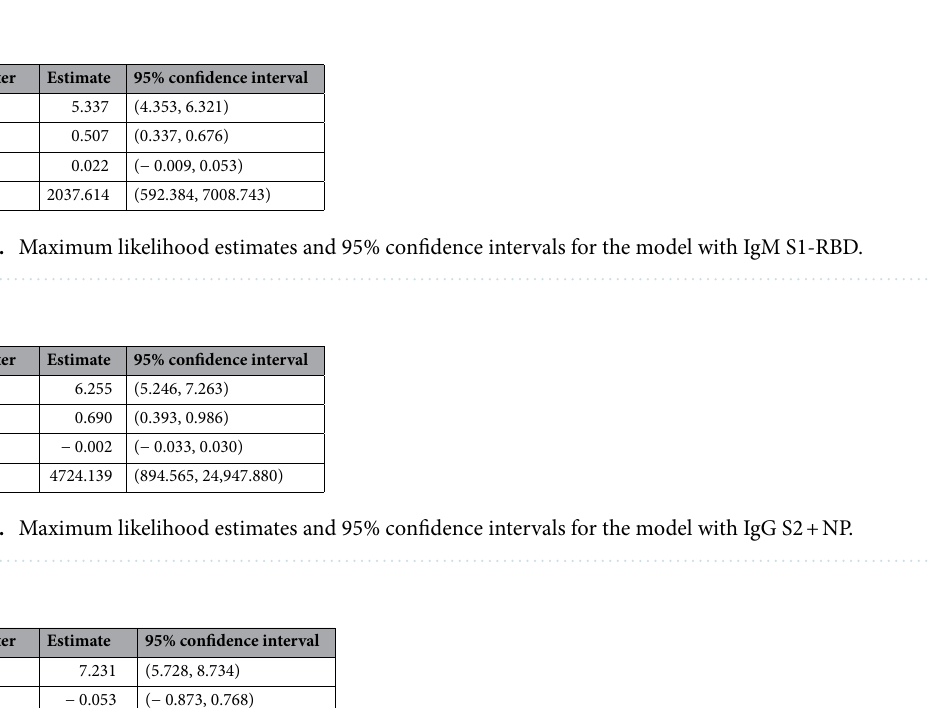
Table 4. Maximum likelihood estimates and 95% confidence intervals for the model with IgG S1-RBD.